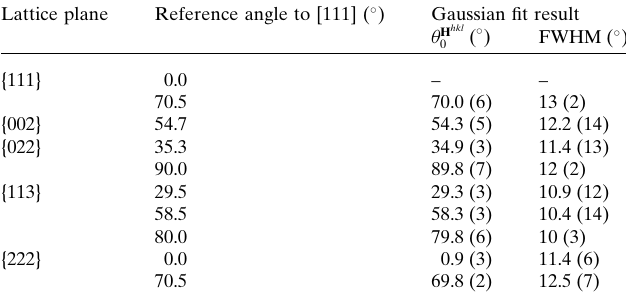
Table 1 Reciprocal-space fiber-plot peak fit results. (cid:5) H hkl is the fitted peak position. 0 Lattice plane